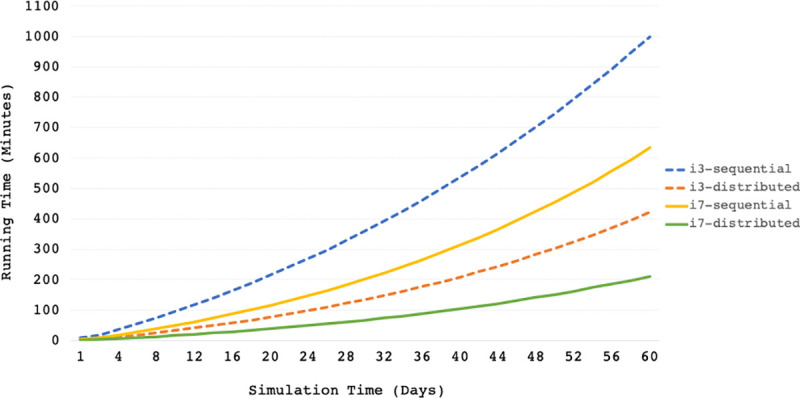
Computational burden of simulating a virtual clinical trial of 16 patients.A comparison between Core i3 and Core i7 processors running 16 virtual patient processes simultaneously using the Development Platform over the cloud (distributed) versus a complete local installation on a physical device (sequential).